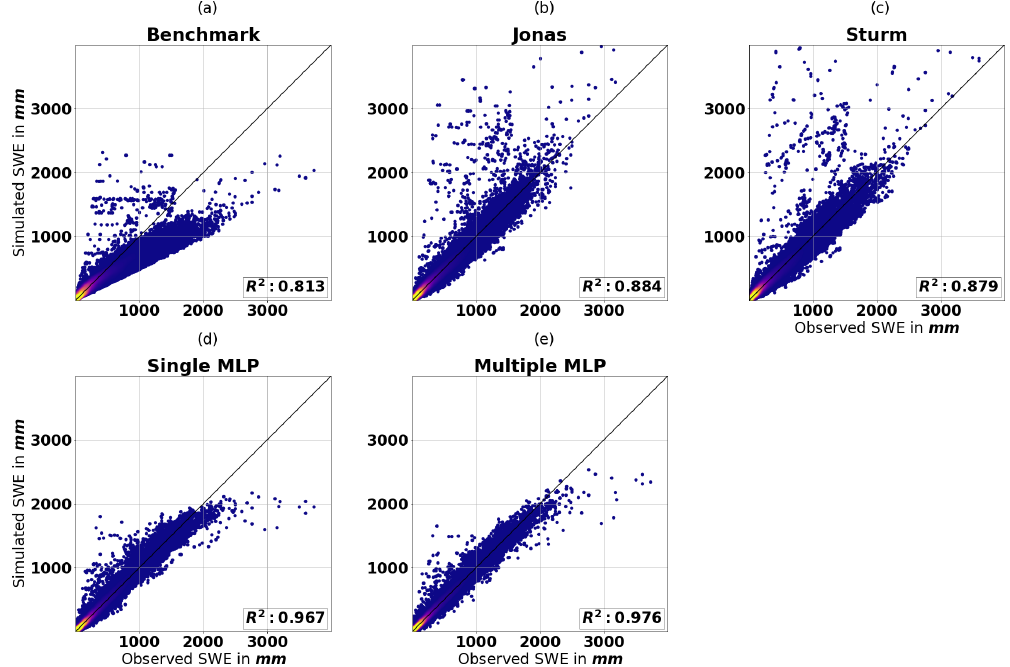
Figure 15. Scatter plot of median of the SWE ensembles and observed SWE for each model, evaluated on the testing data set; note that the axes are cut off at 4000mm; thus, 0 . 03% and 0 . 01% of the data points are not shown for the Jonas and Sturm models,